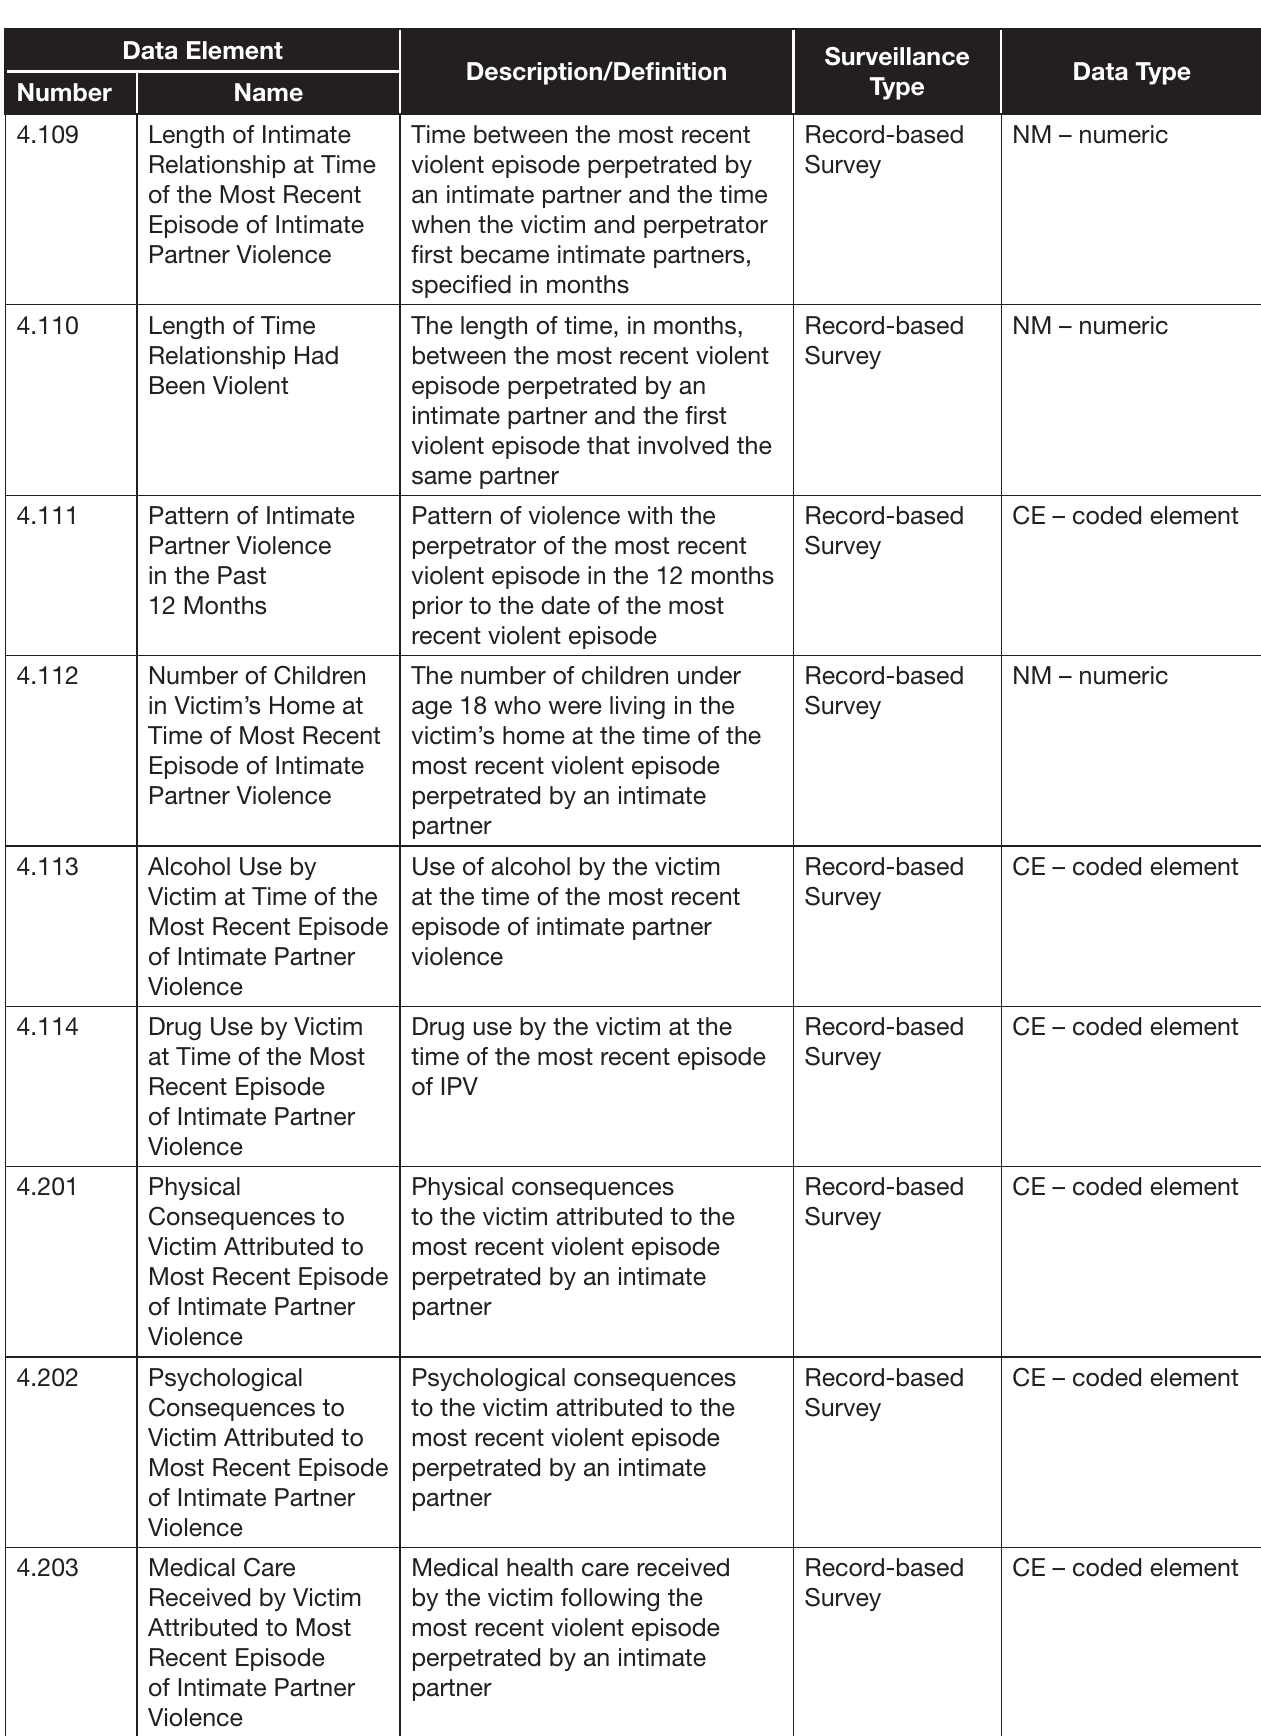
INTIMATE PARTNER VIOLENCE: UNIFORM DEFINITIONS AND RECOMMENDED DATA